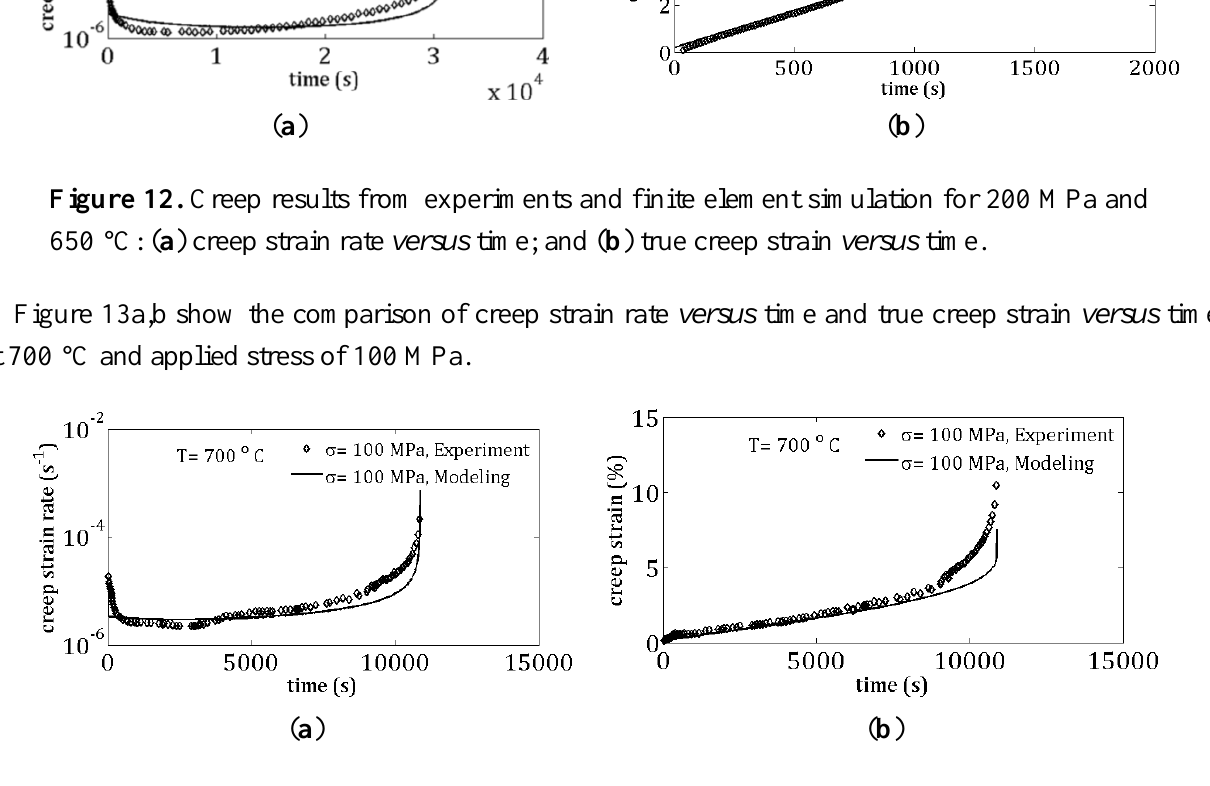
Figure 13. Creep results from experiments and finite element simulation for 100 MPa and 700 °C, ( a ) creep strain rate versus time; and ( b ) true creep strain versus